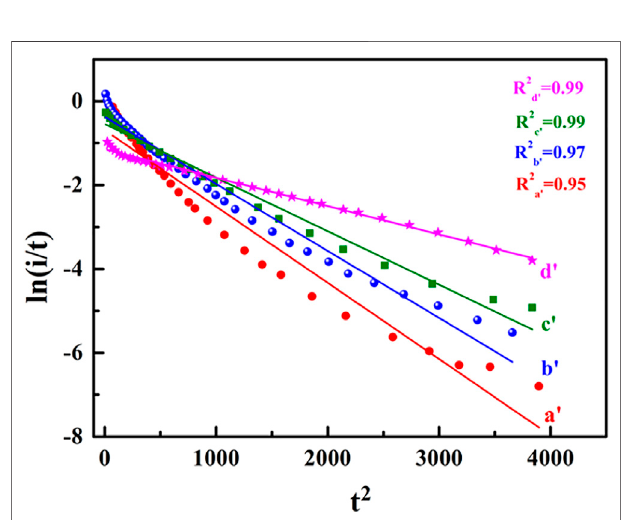
FIGURE 3 | The In (I/t) ~t 2 curves of HCOOH on a single crystal catalyst electrode.